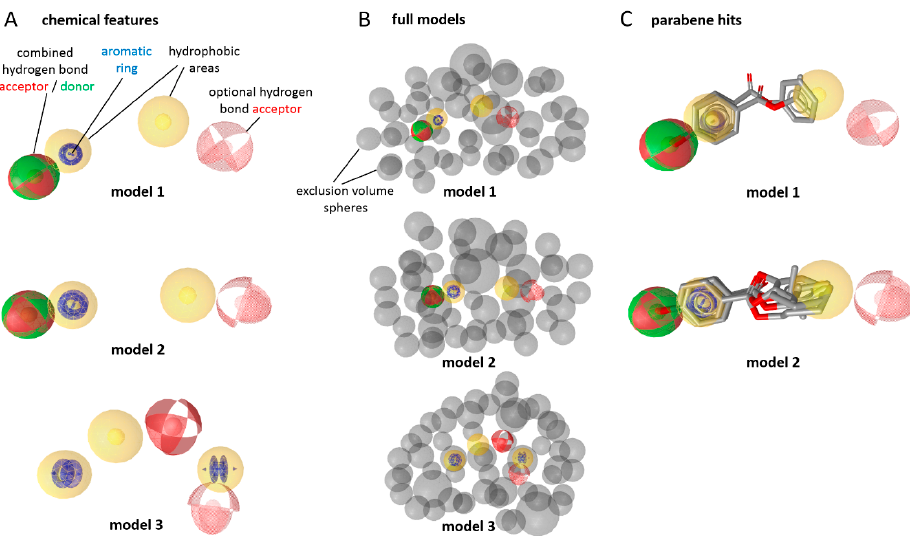
Figure 2. ( A ) Virtual screening strategy using pharmacophore models for 17 β -HSD2 inhibitors